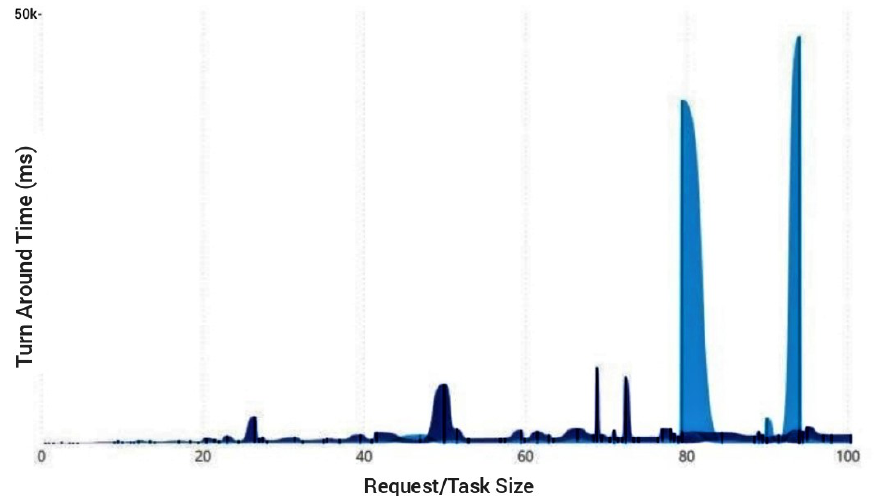
Figure 14. Cumulative turnaround time of C-LBCA vs